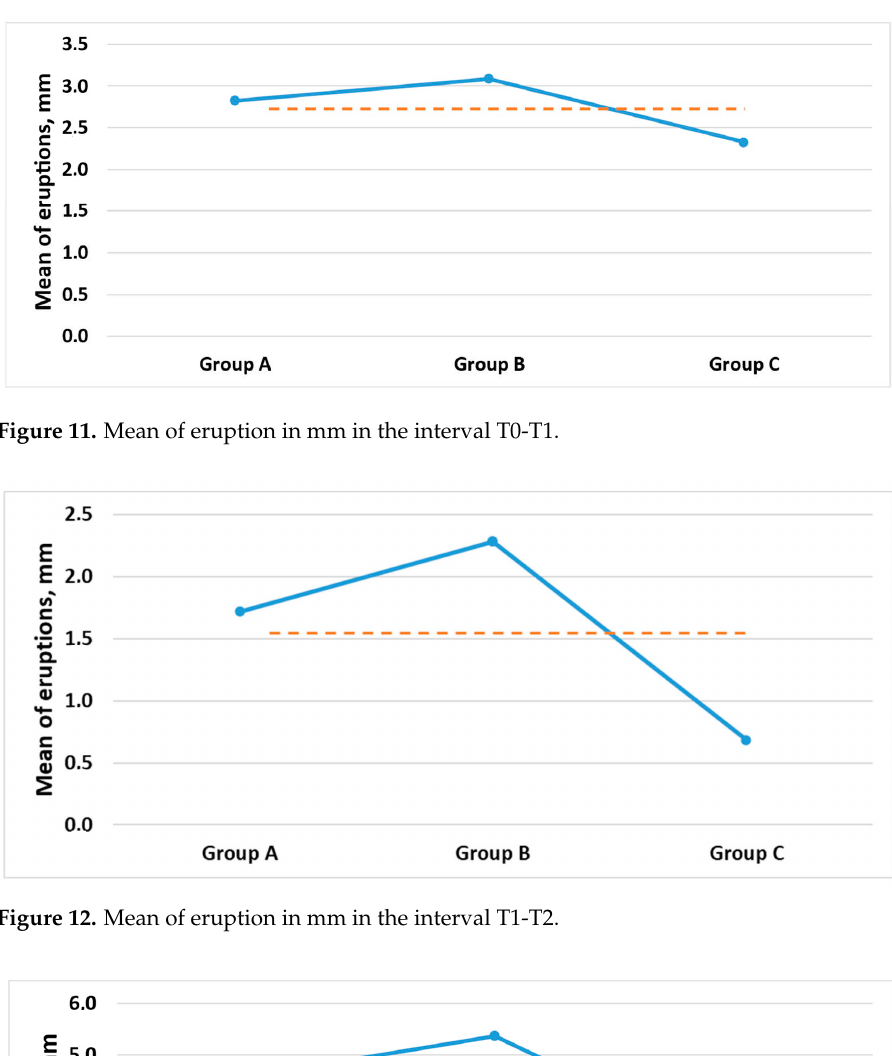
Table 6. Comparison between Groups A, B and C in T0 ‐ T2.